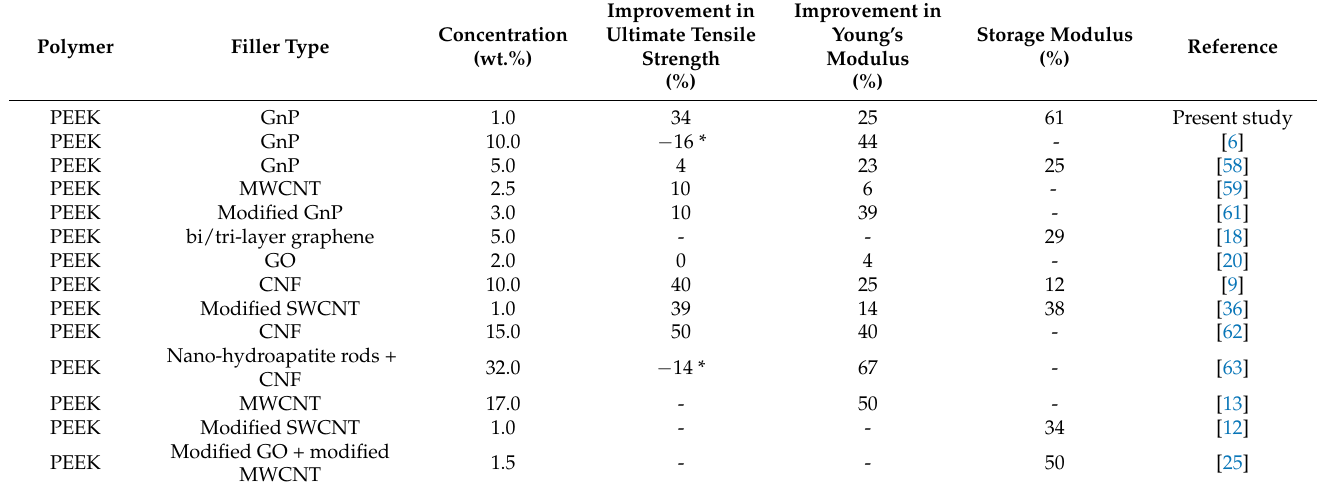
Table 3. Literature review of mechanical properties of the previously reported PEEK